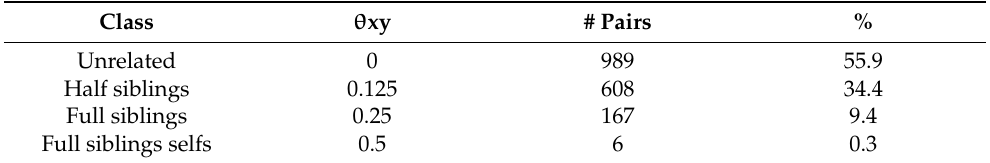
Table 4. Expected pairwise co-ancestry amongst the post-fire seedling cohort, based on the recon- structed pedigree. Class θ xy # Pairs % Unrelated 0 989 55.9 Half siblings 0.125 608 34.4 Full siblings